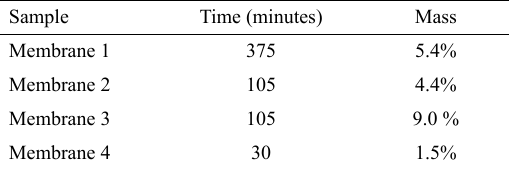
Table 3. Absorption time of the latex membranes.